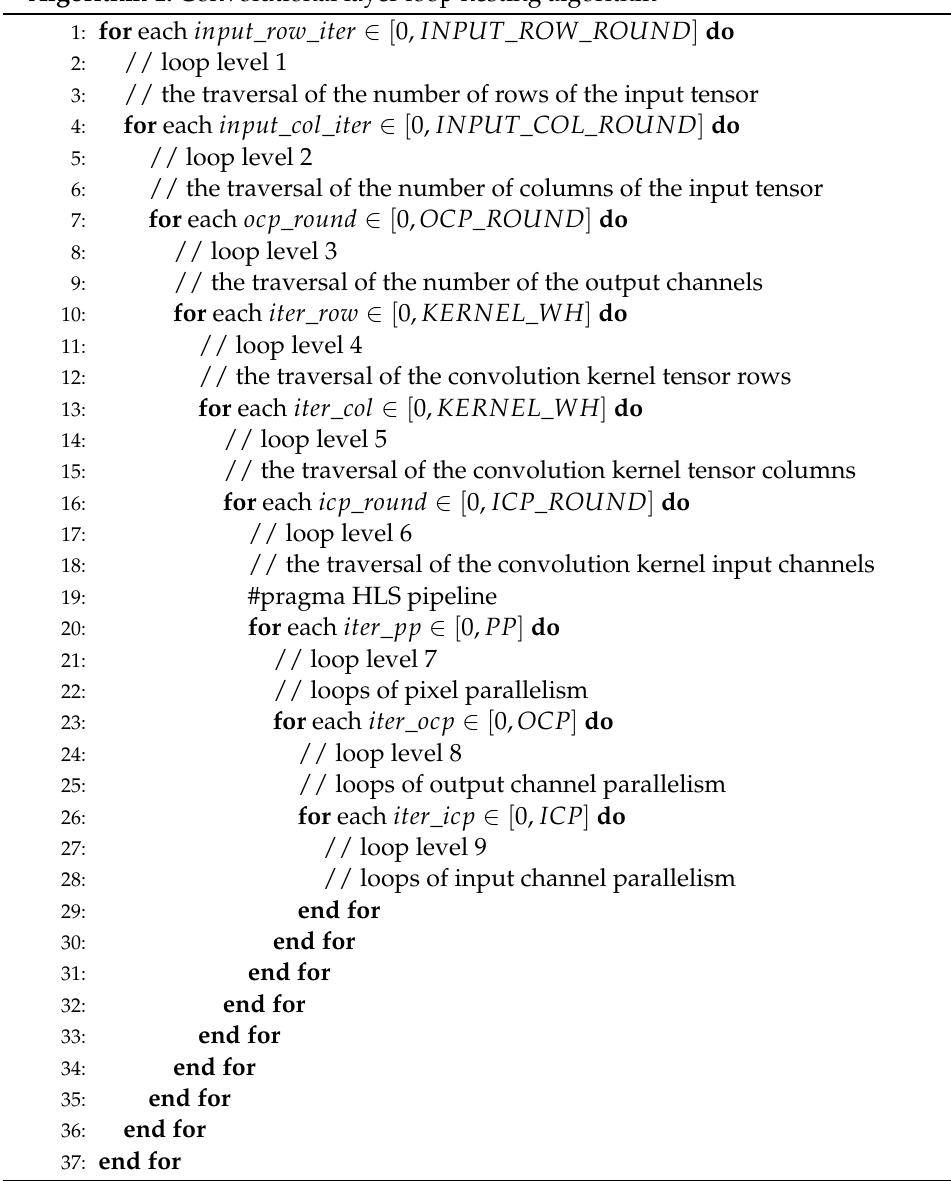
Figure 8. Top: pipeline constraint effect. Bottom: unroll constraint effect. Algorithm 1: Convolutional layer loop nesting